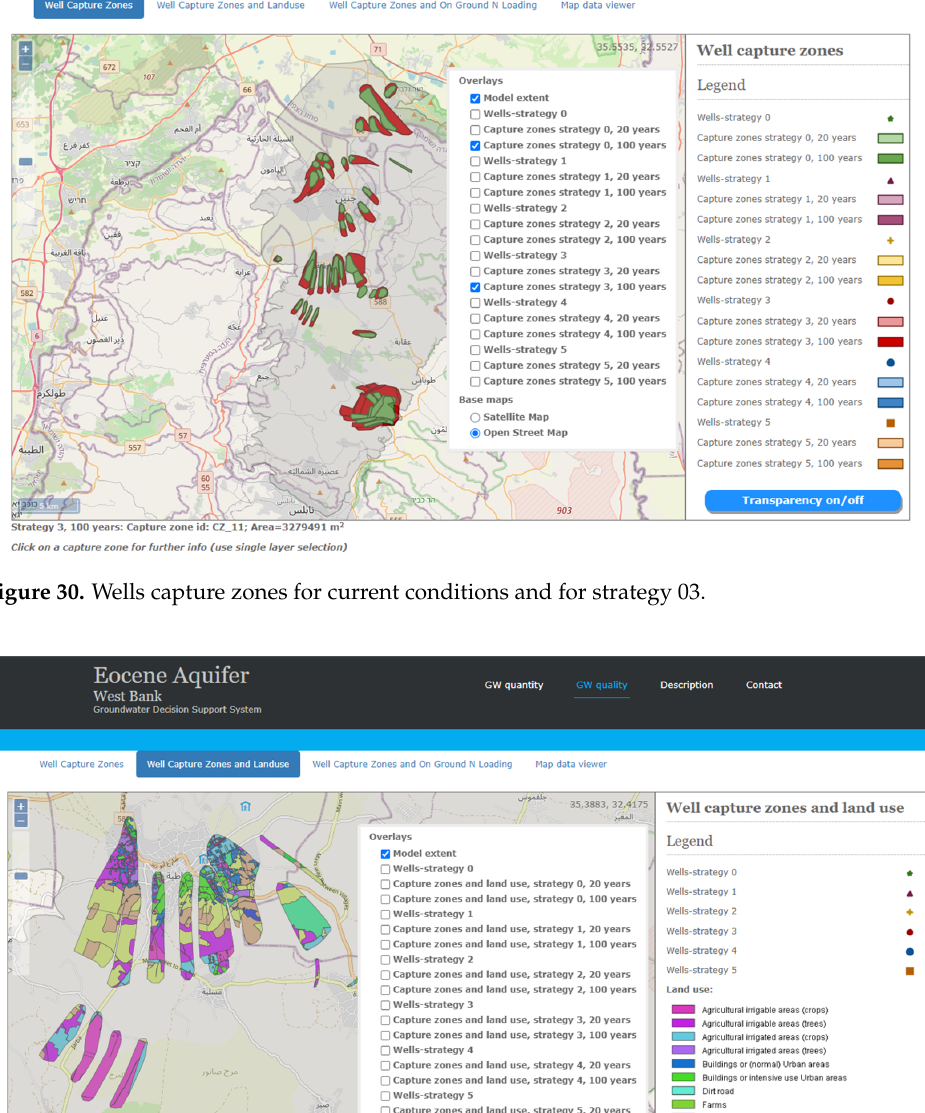
Figure 29. Groundwater head change for Strategy 03 compared to present conditions.